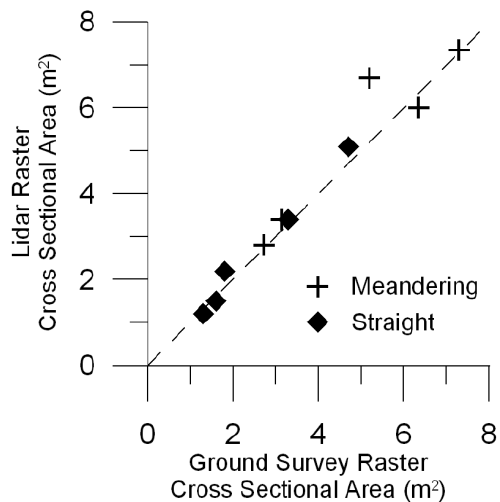
Figure 7. Comparison of cross-sectional wet areas below an arbitrary water surface elevation in the meandering and straight channel study reaches, calculated from ground survey and EAARL-derived rasters. Dashed line is a 1:1 correspondence.